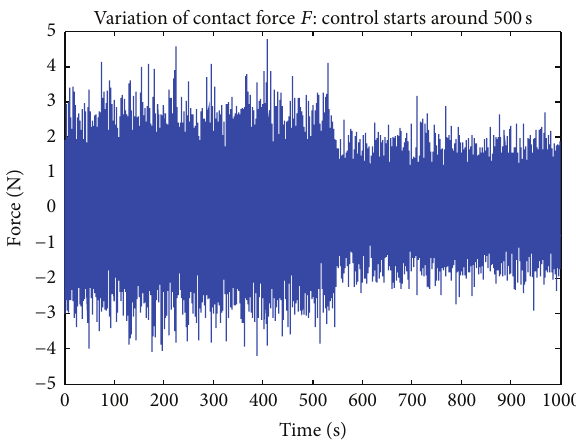
Figure 6: The reduction of variation in contact force 𝐹 for V = 200 m / s.